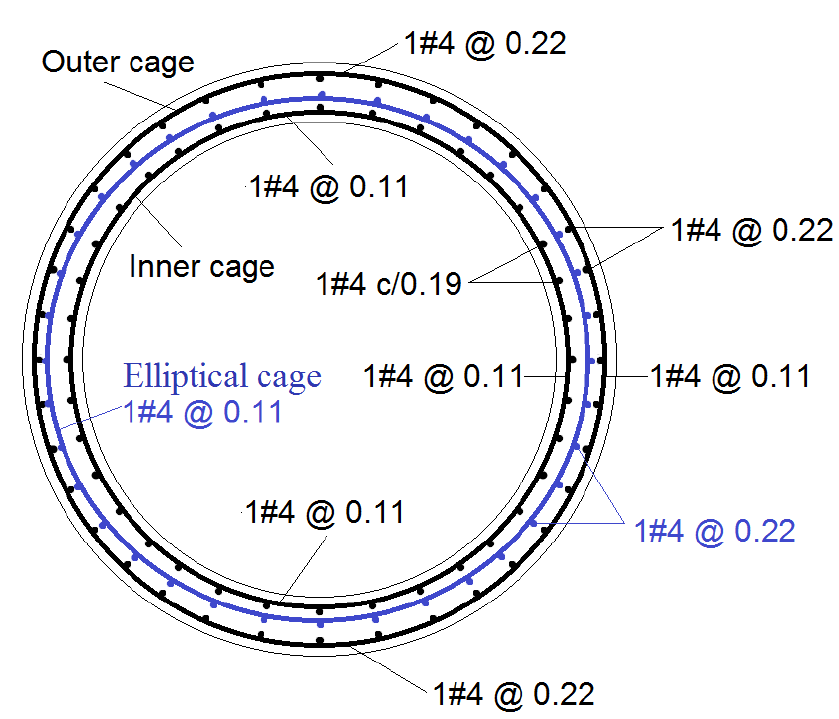
Figure 4. Steel reinforcement in a typical section. No detailing steel reinforcement is shown.